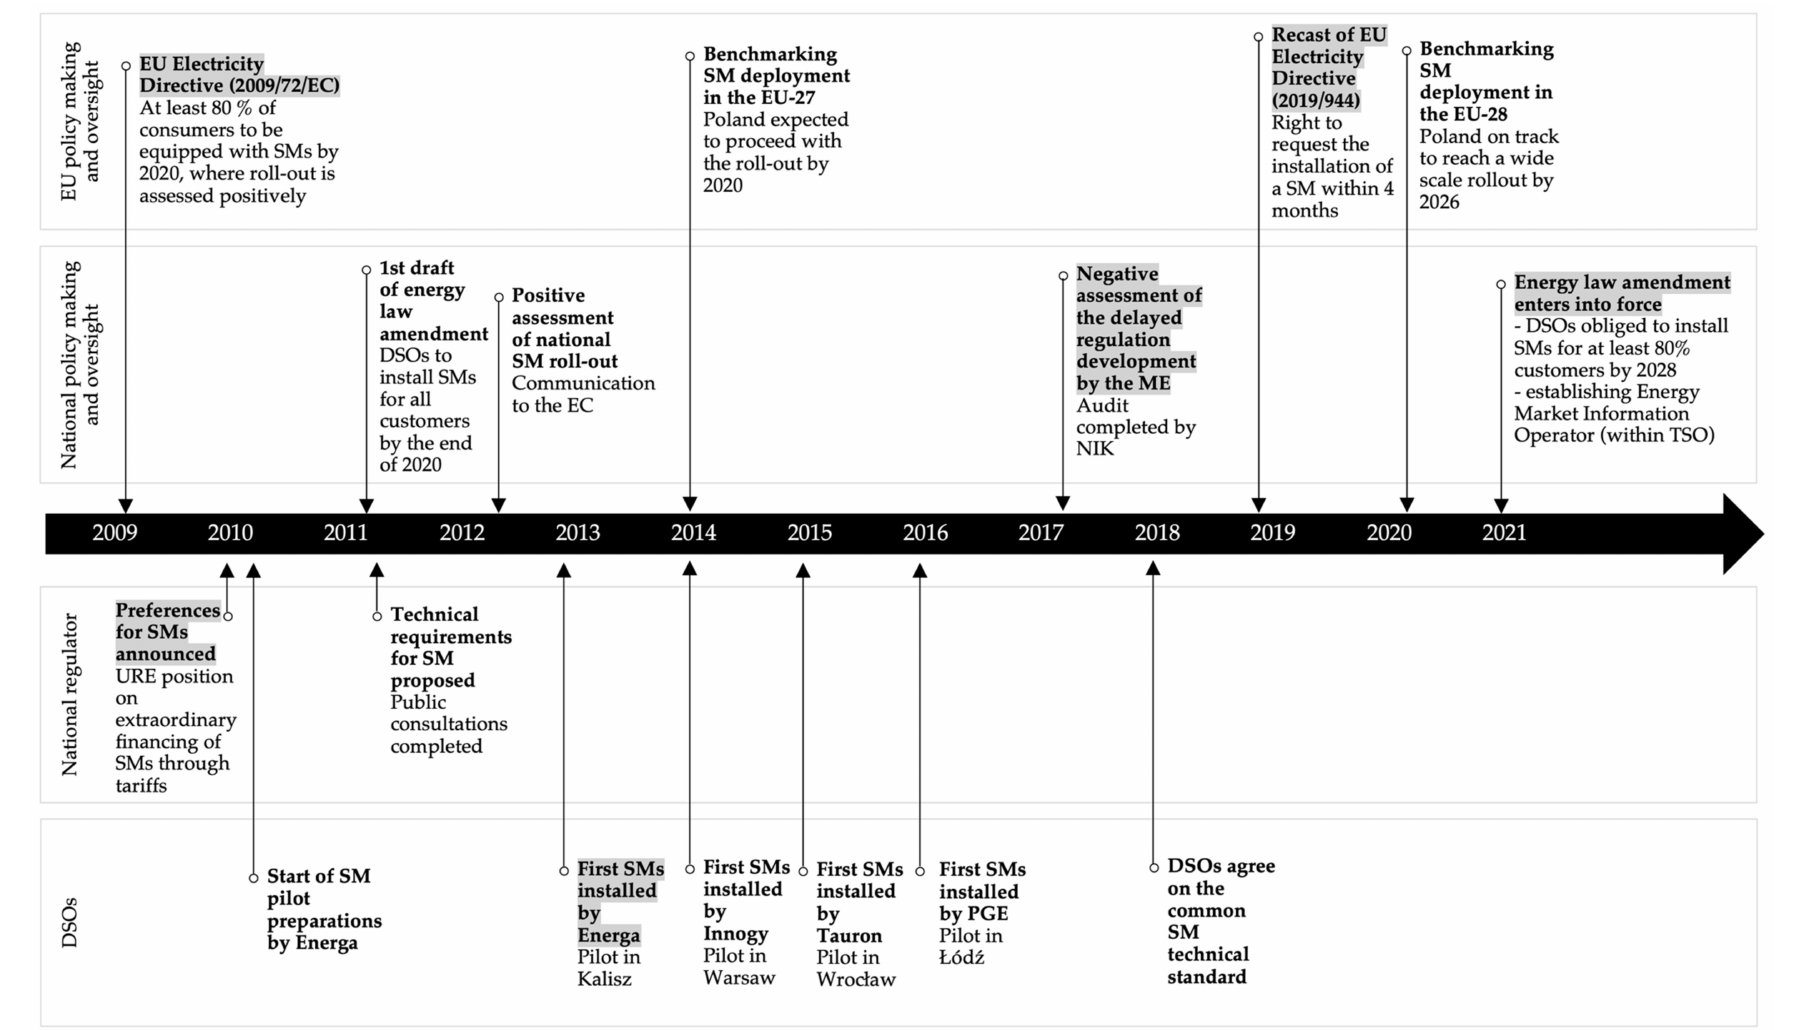
Figure 5. Timeline of market formation and governance processes in the SM rollout in Poland (2009–2021, major milestones highlighted in grey)